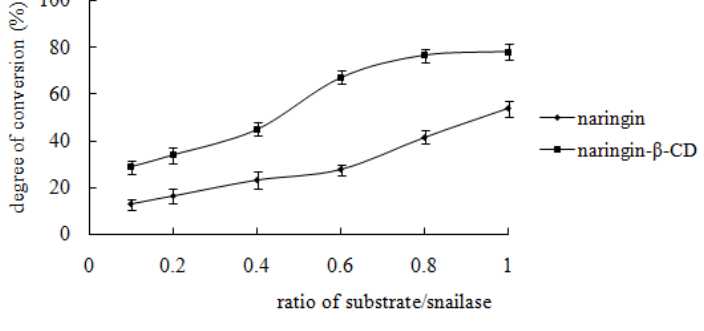
Figure 5. Effect of the ratio of snailase/substrate. Nineteen point six milligrams of inclusion complex (containing 10 mg naringin) or 10 mg free naringin was mixed with 1, 2, 4, 6, 8, 10 mg snailase (snailase/substrate = 0.1, 0.2, 0.4, 0.6, 0.8, and 1). Glacial acetic acid and sodium acetate anhydrous buffer (pH 4.5) was added to the mixture at a final volume of 1 mL. Subsequently, the buffer was incubated in a HH-4 digital constant temperature water bath at 37 °C for 24 h. Each point represented the mean ± SD ( n = 3).